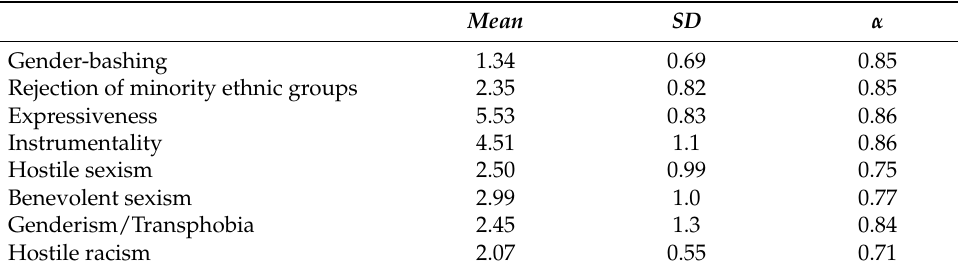
Table 1. Descriptive statistics and reliability of the